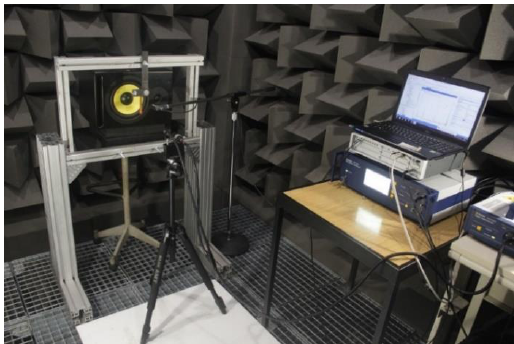
Figure 2. Experimental apparatus for the testing of cantilever beam samples detailing sample cantilever sample fixation, loudspeaker excitation, and measurement instrumentation.